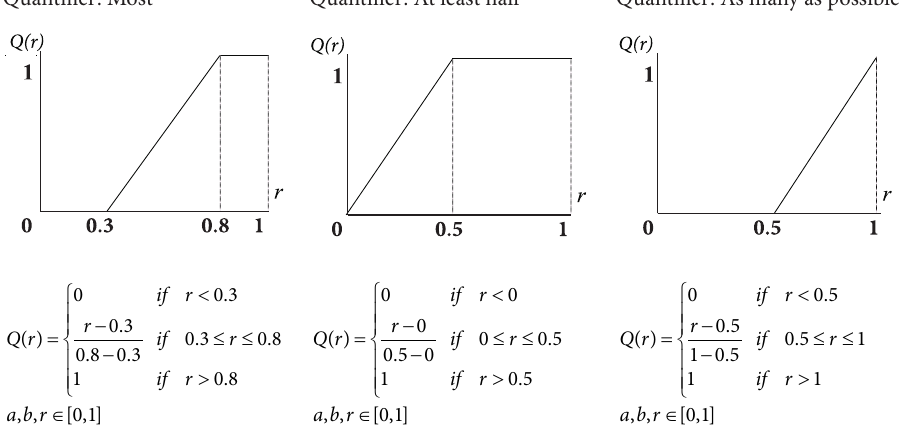
Fig. 2. Monotonically non-decreasing fuzzy linguistic